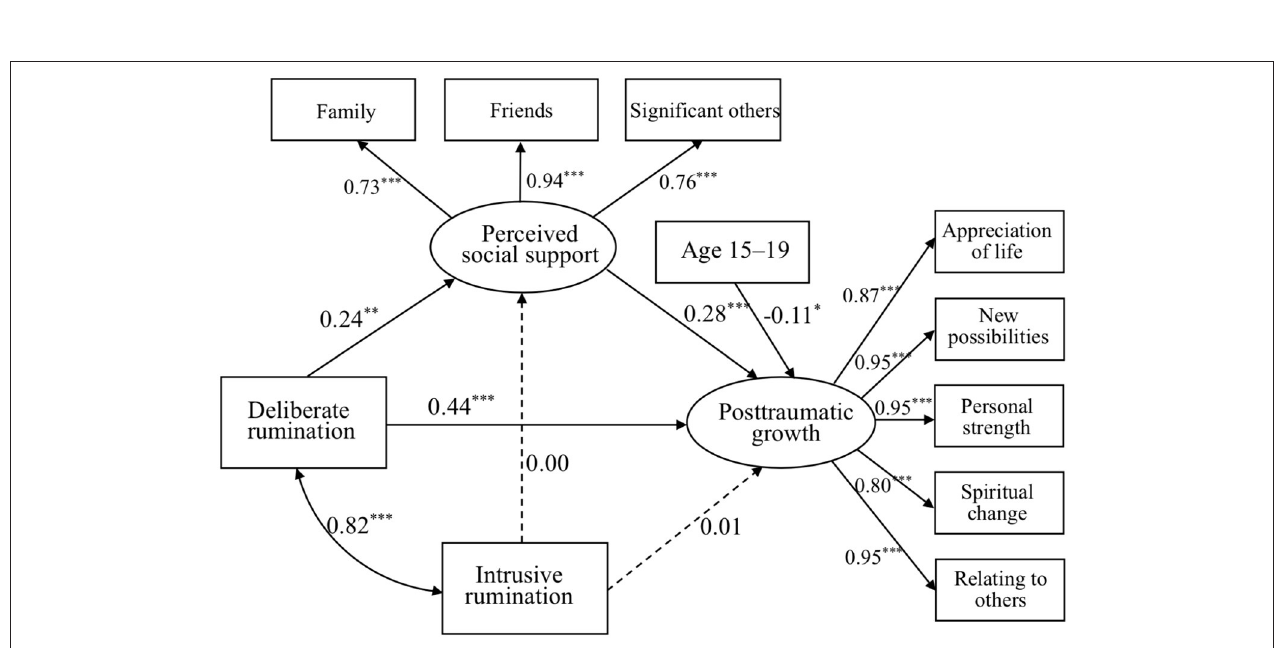
FIGURE 3 | Mediation model of deliberate and intrusive ruminations to PSS and to PTG in age 15–19 sample. * p < 0.05, ** p < 0.01, and *** p < 0.001.